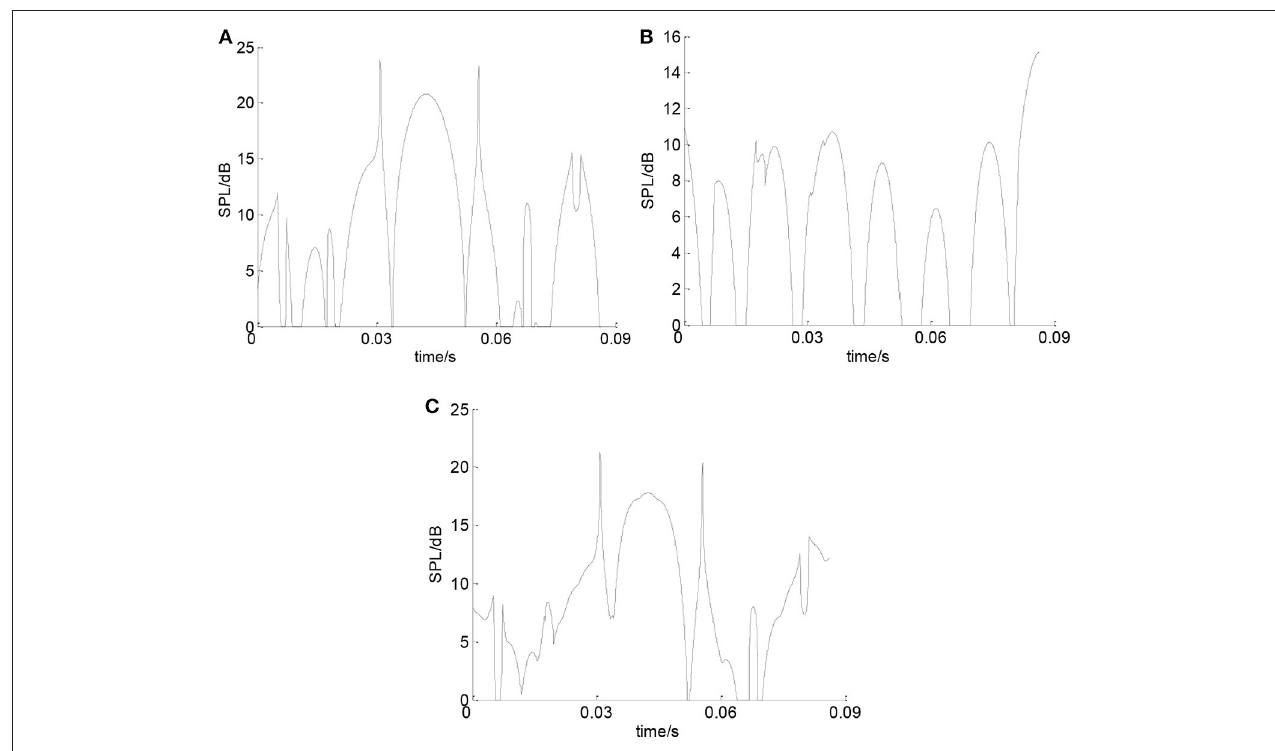
FIGURE 12 | The SPL of the inner ring. (A) SPL of inner ring in X direction. (B) SPL of inner ring in Y direction. (C) Total SPL of the inner ring.